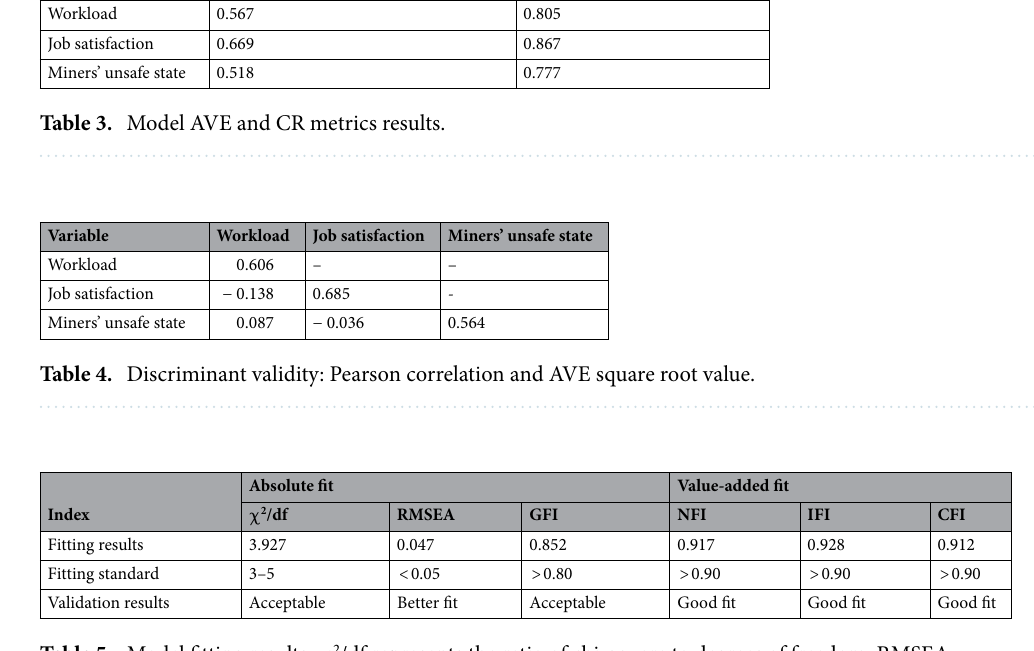
Table 5. Model fitting results. χ 2 /df represents the ratio of chi-square to degrees of freedom. RMSEA represents the root mean square error of approximation. GFI represents fitness index. NFI represents normed fit index. CFI represents comparative fit index.